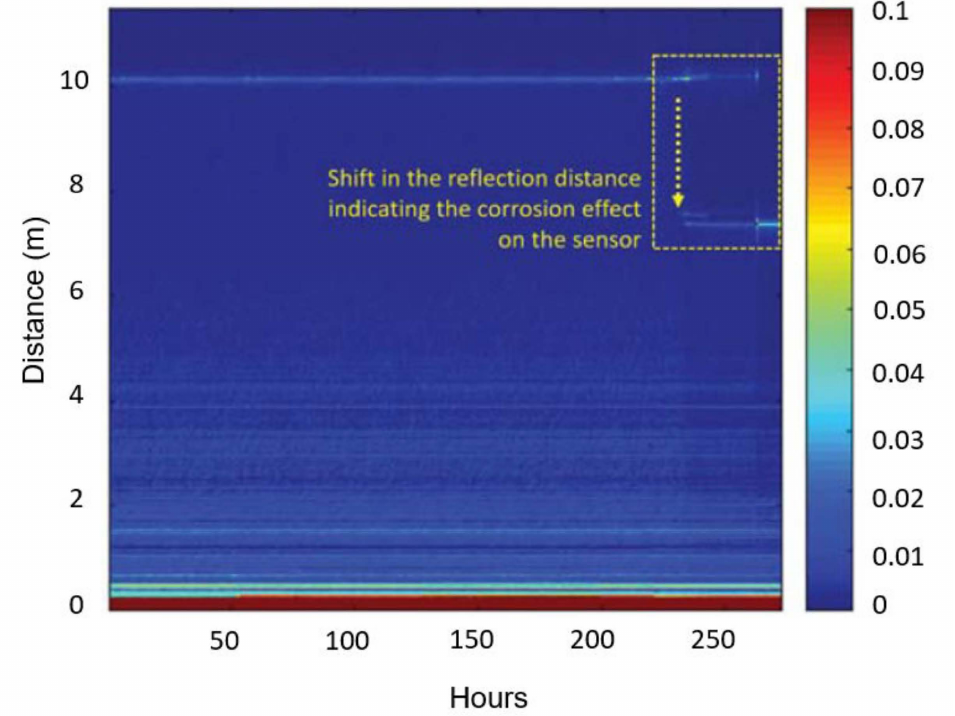
Figure 11. The spectrogram of reflected signals collected from a corrosion sensor, which indi- cates the location of the corrosion initiation part of a pipe. Reprinted with permission from Ref. [98]